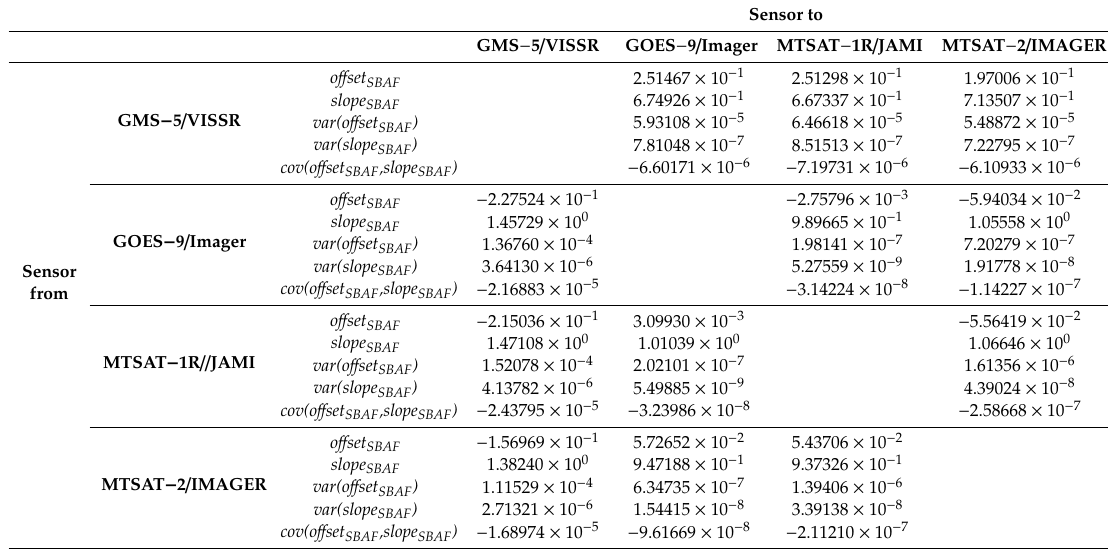
Table A4. SBAFs for converting WV channel radiances between di ff erent historical JMA satellites (unit: mW / (m 2 sr cm − 1 )).